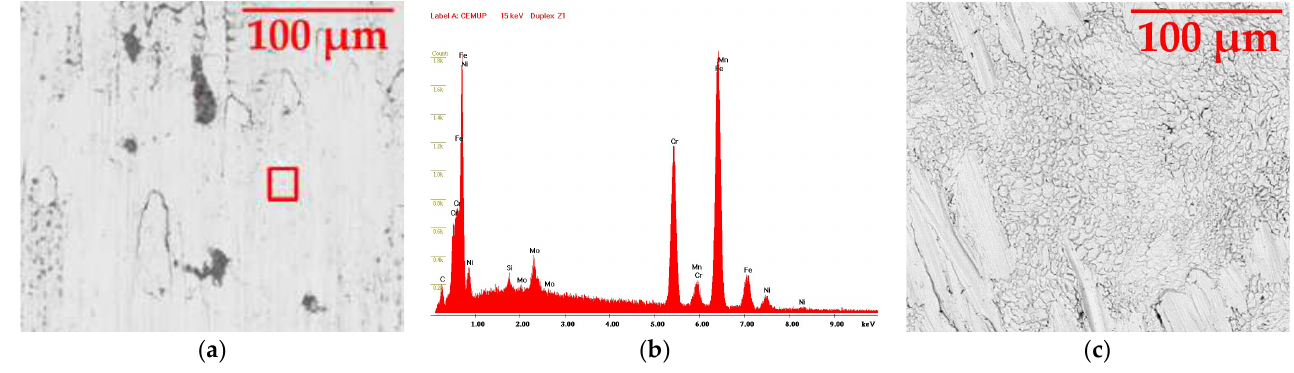
Figure 8. SEM image of the Duplex 14462 sample: ( a ) after three weeks with 500× magnification, ( b ) EDS of the red zone in the first image and ( c ) after three months with 1000× magnification.